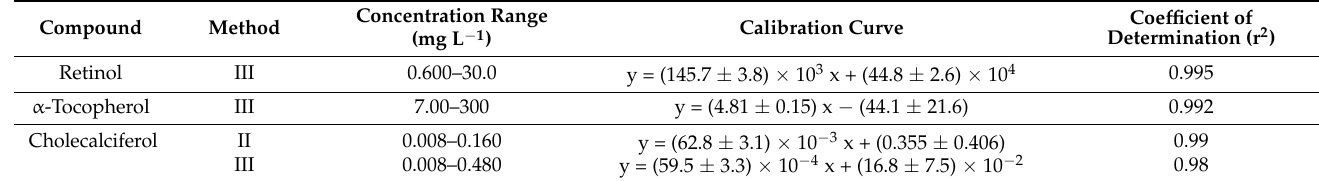
Table 4. Matrix-matched curves and correlation factors for each